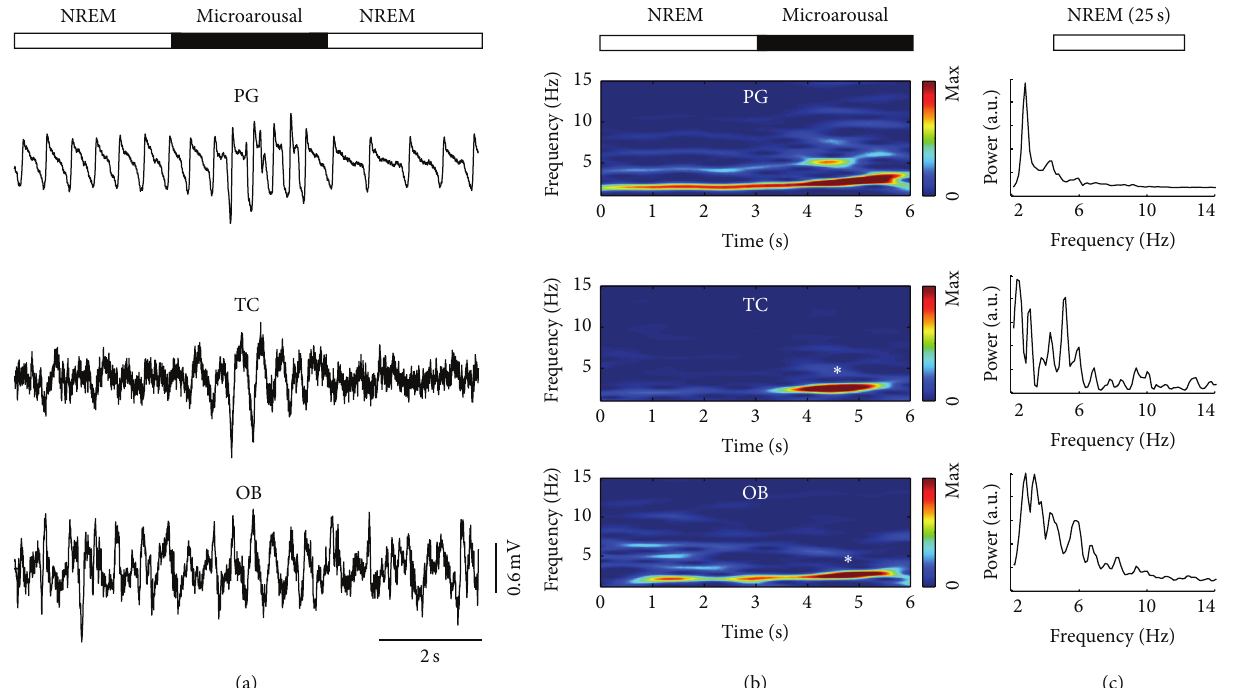
Figure 4: During NREM sleep only plethysmography reliably reflects respiration except during microarousals. (a) Raw signal of plethysmography (PG), thermocouple (TC), and olfactory bulb local field potential (OB). (b) Time-frequency distribution of the three signals shown in (a). (c) Power spectral density of NREM sleep reveals a clear peak in PG but no corresponding peaks in TC and OB. During microarousals (see asterisks), all three signals indicate